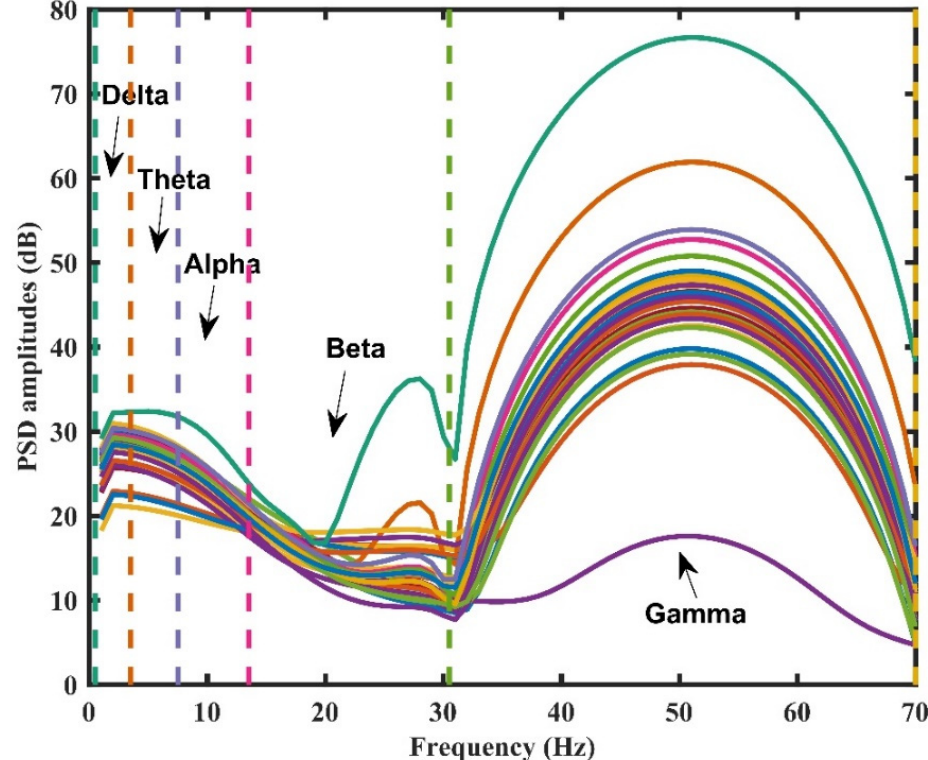
Figure 2. PSD feature extraction of a single participant based on EEG rhythm, which corresponds to a particular concentration of the rose odor, i.e., the A10 − 5.0 . Each color corresponds to an EEG electrode. EEG, electroencephalogram; PSD, power spectral density.